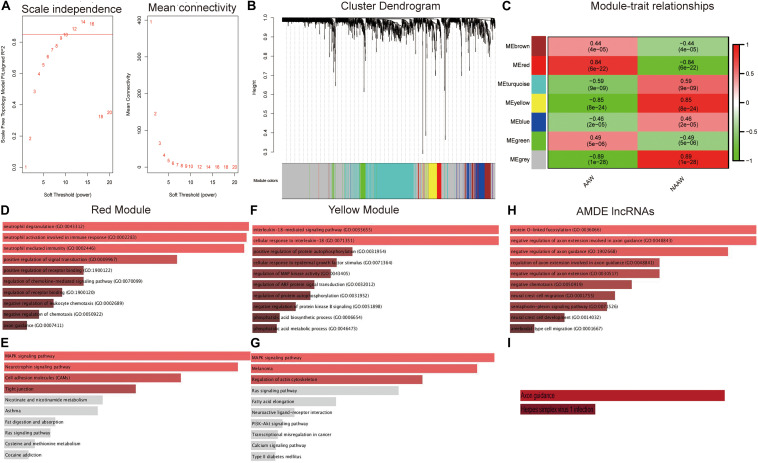
Weighted correlation network analysis (WGCNA) and functional analysis of the aberrantly methylated–differentially expressed (AMDE) genes: (A) scale-free networks of scale independence and mean connectivity, (B) clustering dendrogram of AMDE mRNAs obtained by WGCNA, (C) the relationship of each WGCNA module in the normal and atherosclerotic artery wall samples, (D) Gene Ontology (GO) analysis of the AMDE mRNAs in the red module, (E) Kyoto Encyclopedia of Genes and Genomes (KEGG) analysis of the AMDE mRNAs in the red module, (F) GO analysis of the AMDE mRNAs in the yellow module, (G) KEGG analysis of the AMDE lncRNAs in the yellow module, (H) GO analysis of the AMDE lncRNAs, and (I) KEGG analysis of the AMDE lncRNAs.